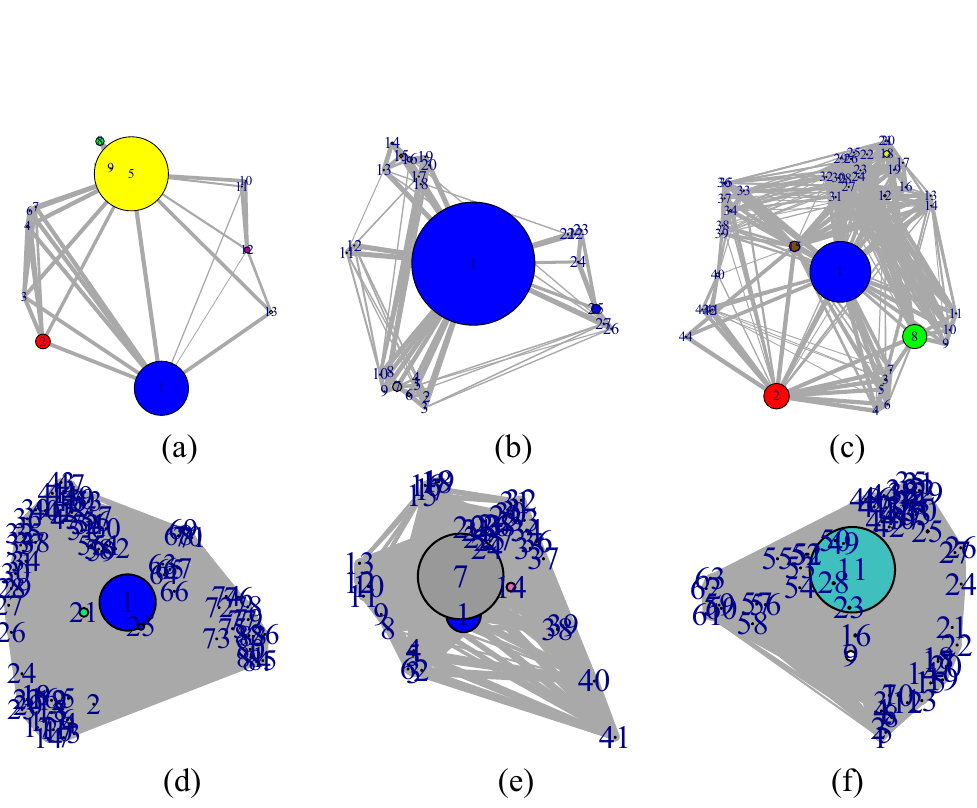
Figure 6. The community cluster modules of structures ( a ) WT-human, ( b ) G51D-slow, ( c ) E46K-fast, ( d ) H50Q, ( e ) A53T and ( f ) A30P after performing modularity